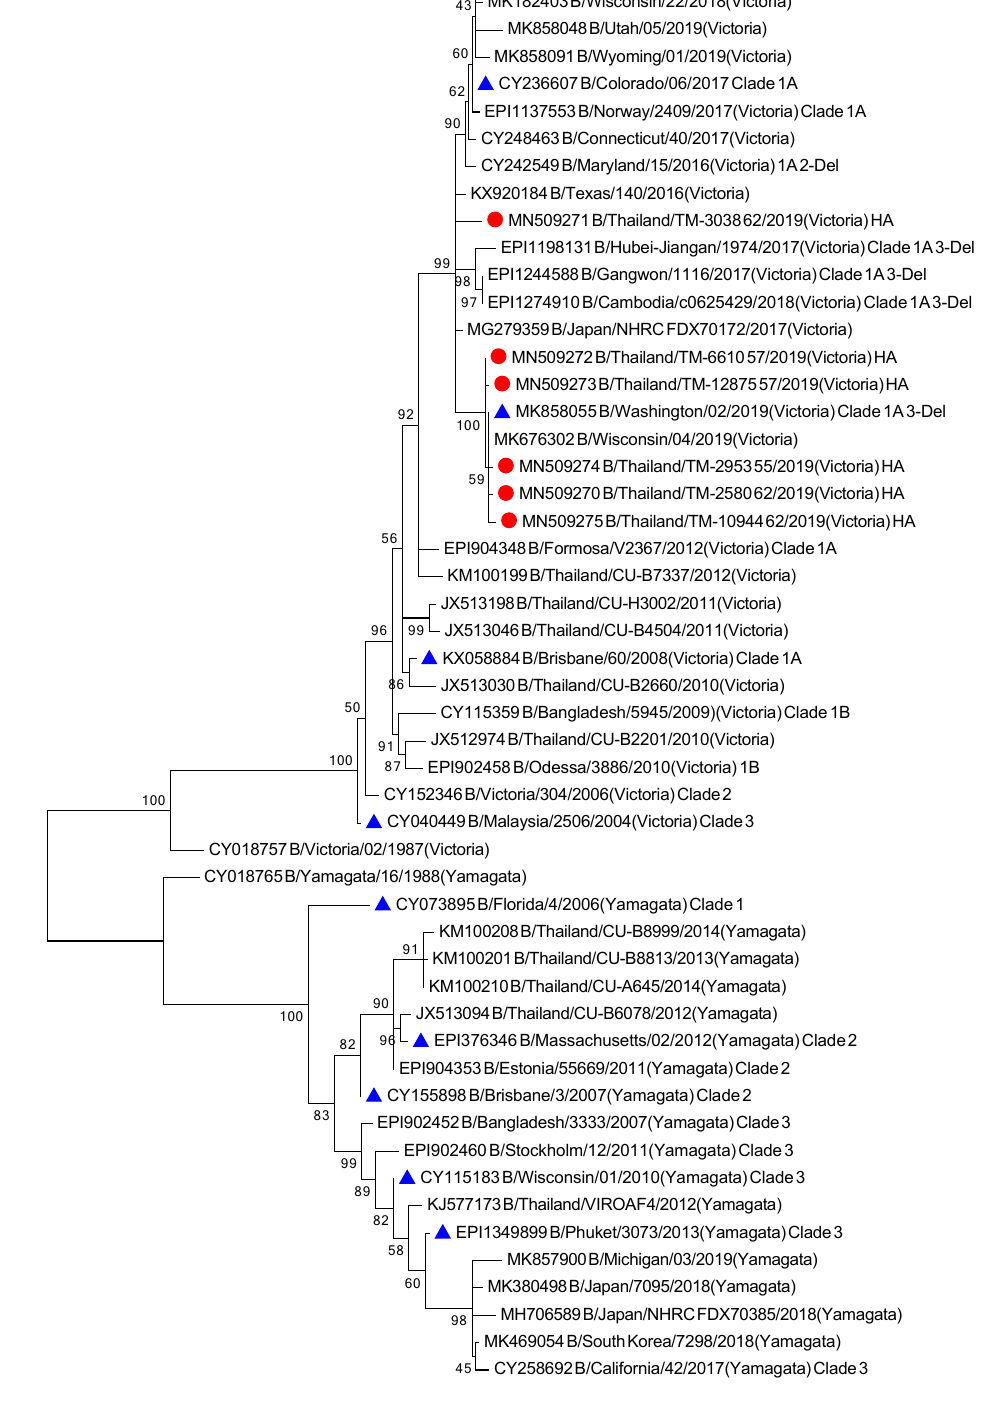
Figure 6. Phylogenetic tree of concatenate from all 8 genes of influenza B/Vic Thai strains was inferred by using the Maximum Likelihood method based on the Tamura 3-parameter model. Red circles indicate B/Victoria Thai isolates and blue triangles indicate influenza B vaccine strains.